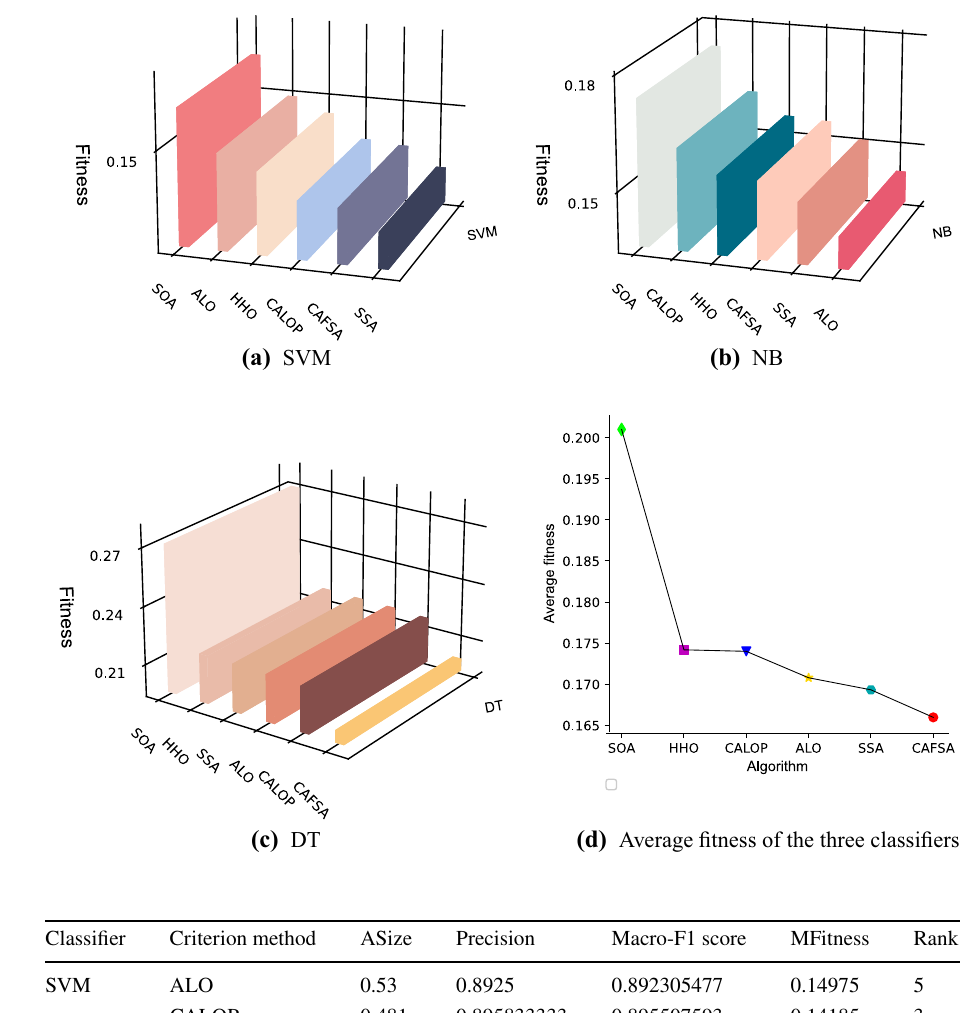
of six intelligent algorithms on the